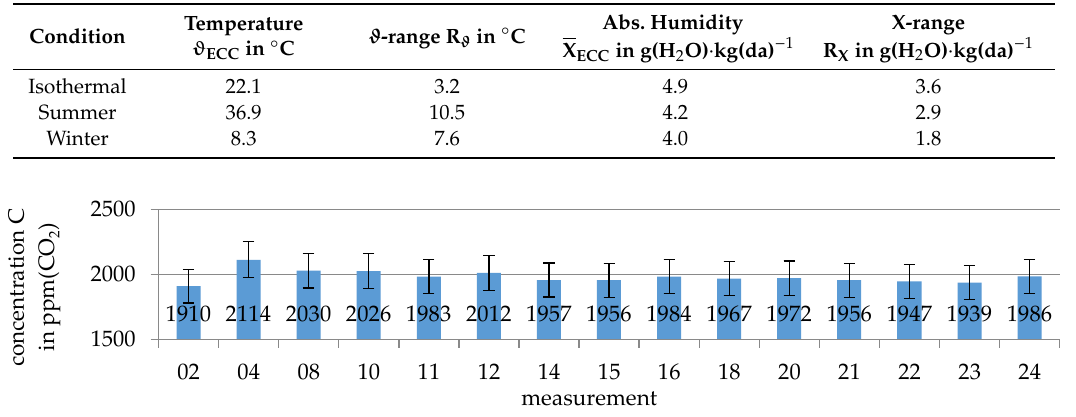
Table 5. Hygrothermal conditions in external climatic chamber (ECC) over 4 measurements each. Condition